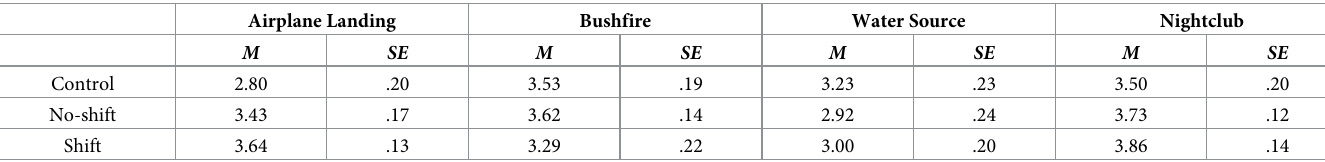
Table 1. Descriptive statistics for memory scores across scenarios and conditions. Airplane